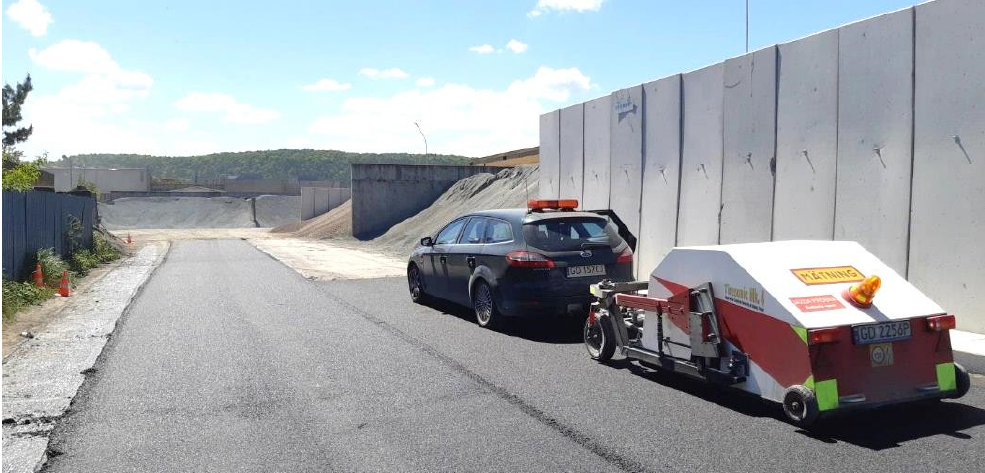
Figure 7. Tyre/road noise measurements using the CPX method.